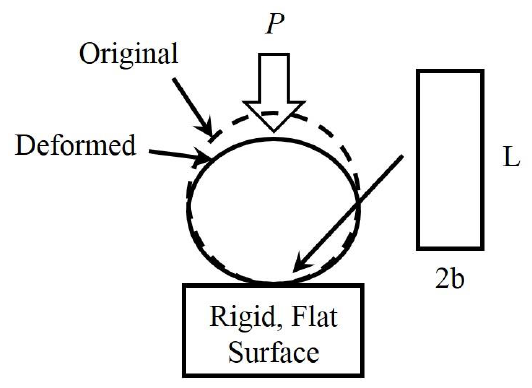
Figure 1. Schematic of contact between a cylinder and a rigid flat